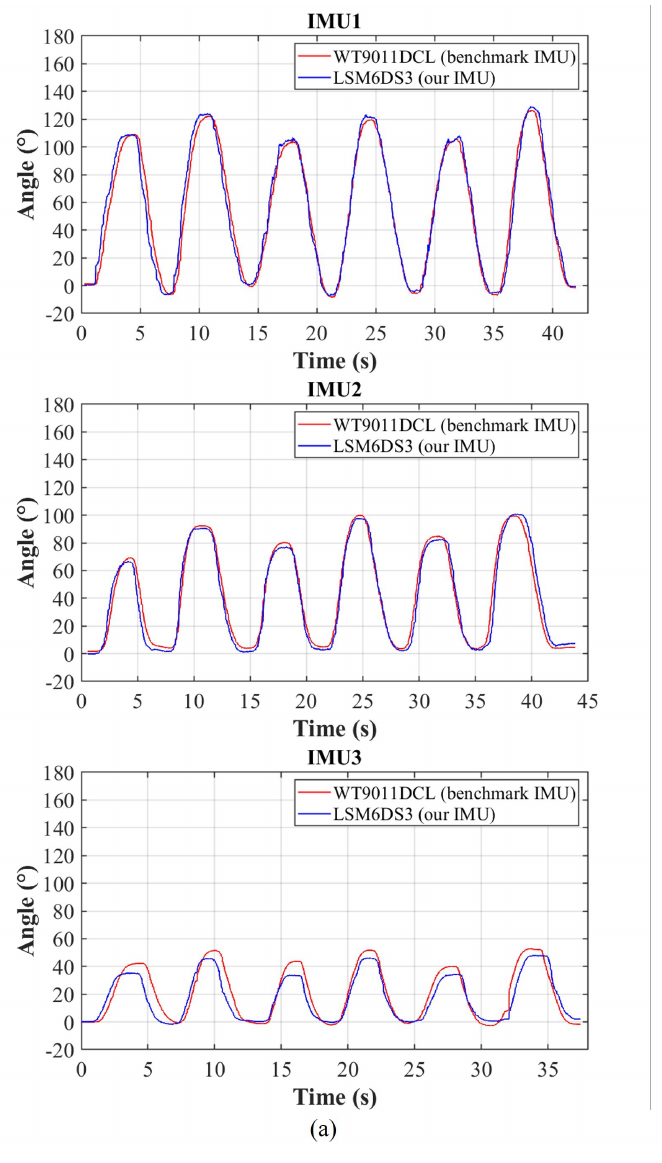
Figure 10. Comparison of benchmark and our IMU results for dynamic tests for ( a ) the thumb and ( b ) index finger.